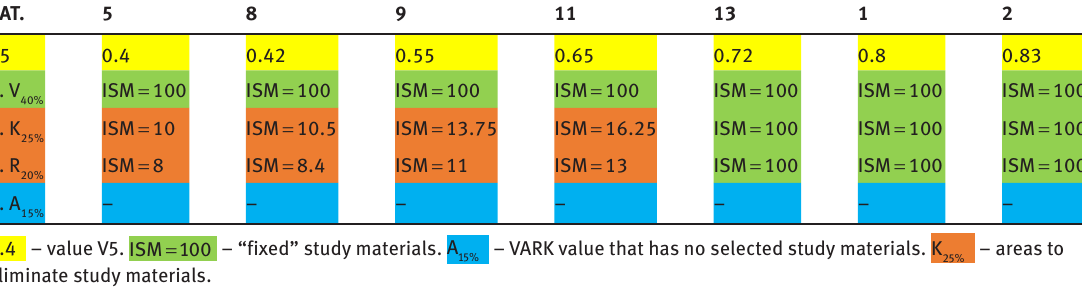
Table 1: Sample Values to Create a Reduced Study Plan.